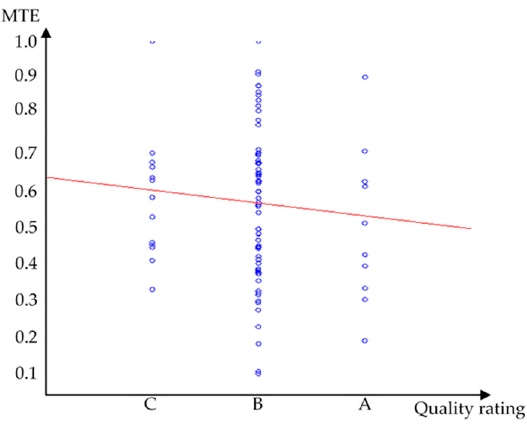
Figure 5. The relation between MTE results and quality rating. Table 12. Impact of quality of care on MTE efficiency.